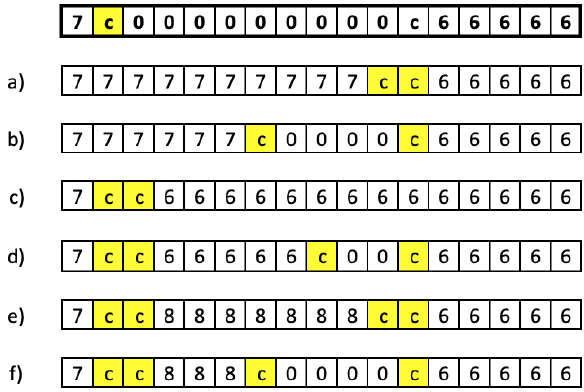
Figure 5. Examples of neighborhood definition 3: ( a ) corresponds to an injection with the same mold that was used before the gap and covers the entire gap, where the mold used afterwards is different, ( b ) is the same as (a) but the gap is not completely covered, where the mold has to be removed leaving a smaller gap, ( c ) corresponds to an injection of a different mold than the one used before the gap, covering the entire gap, where the same mold is used afterwards (there is no change of mold at the end of the gap), ( d ) is the same as (c) but the gap is not completely covered, where the mold is removed leaving a smaller gap, ( e ) corresponds to an injection of a different mold from the one before and after the gap which covers the entire gap, and, finally, ( f ) is the same as (e) but the gap is not completely covered, where the mold has to be removed leaving a smaller